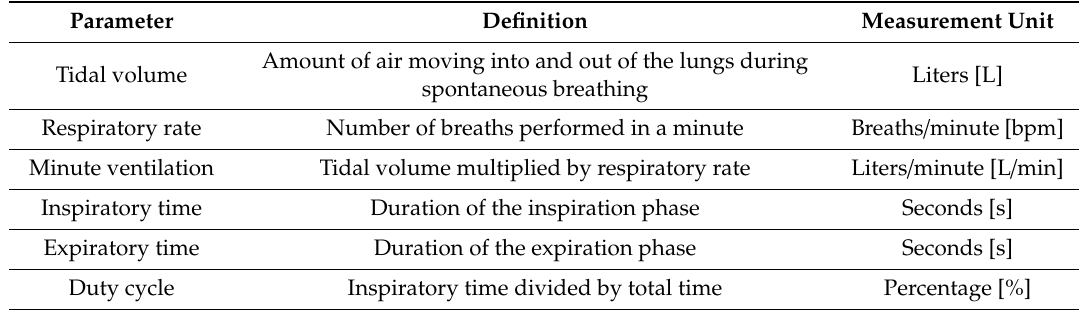
Table 1. Definitions and measurement units of the parameters computed during the tests. In the case of tidal volume and minute ventilation, Airgo ™ does not provide absolute